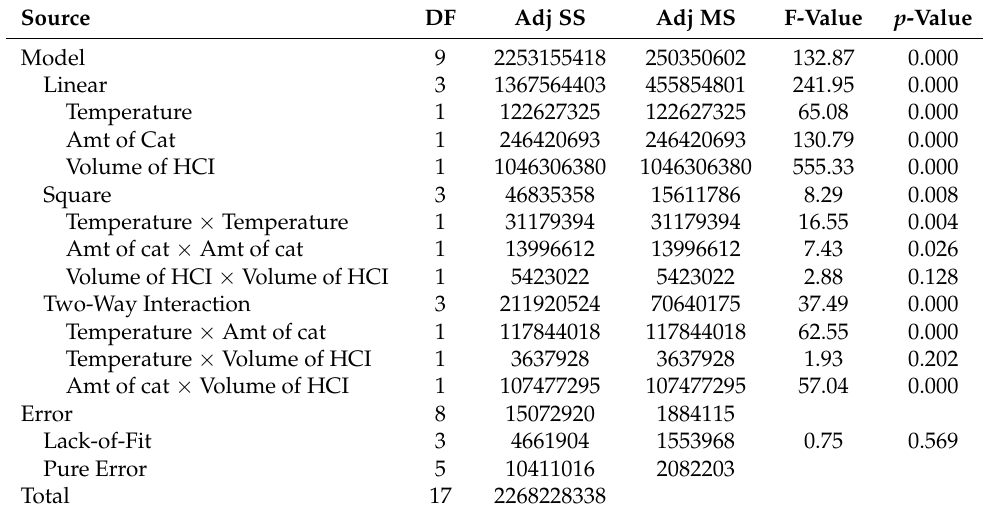
Table 3. Analysis of variance for NiV experiment